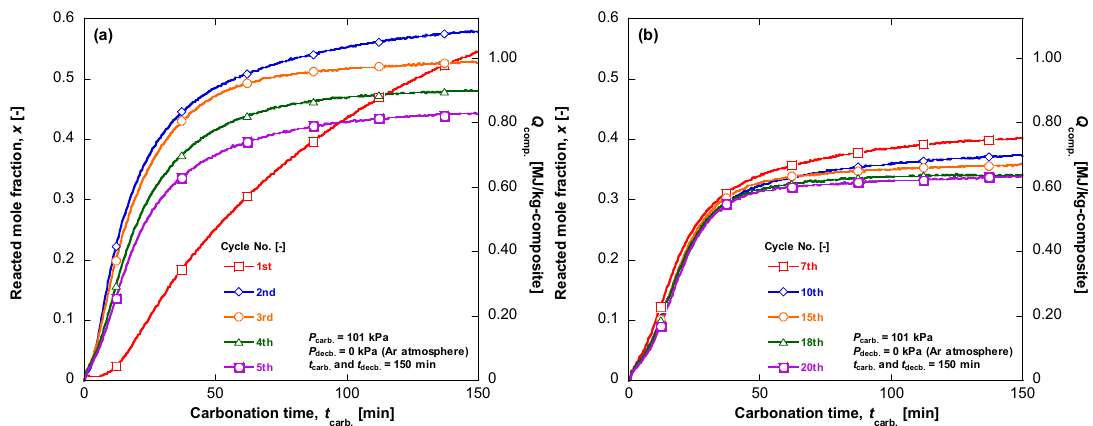
Figure 12. Change in the reacted mole fraction during the cyclic experiment: ( a ) 1st–5th cycles and ( b ) 7th–20th cycles.